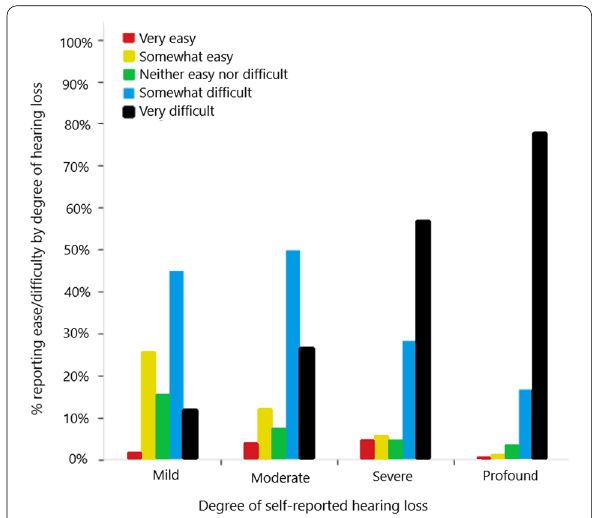
Fig. 1 Reported difficulty of understanding those wearing face masks by degree of self-reported hearing